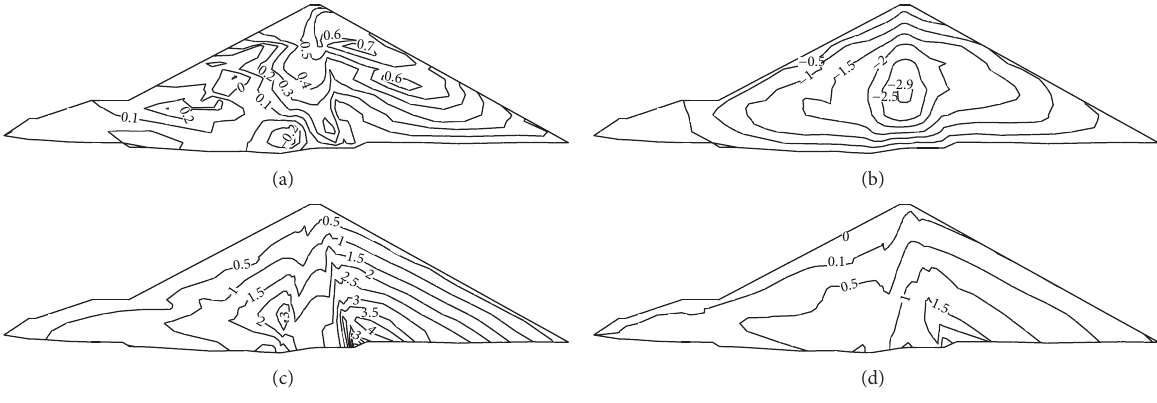
Figure 12: Displacement and stress contour of the maximum section for the modified PZ-III model: (a) displacement along river (m), (b) vertical displacement (m), (c) major principle stress (MPa), and (d) minor principle stress